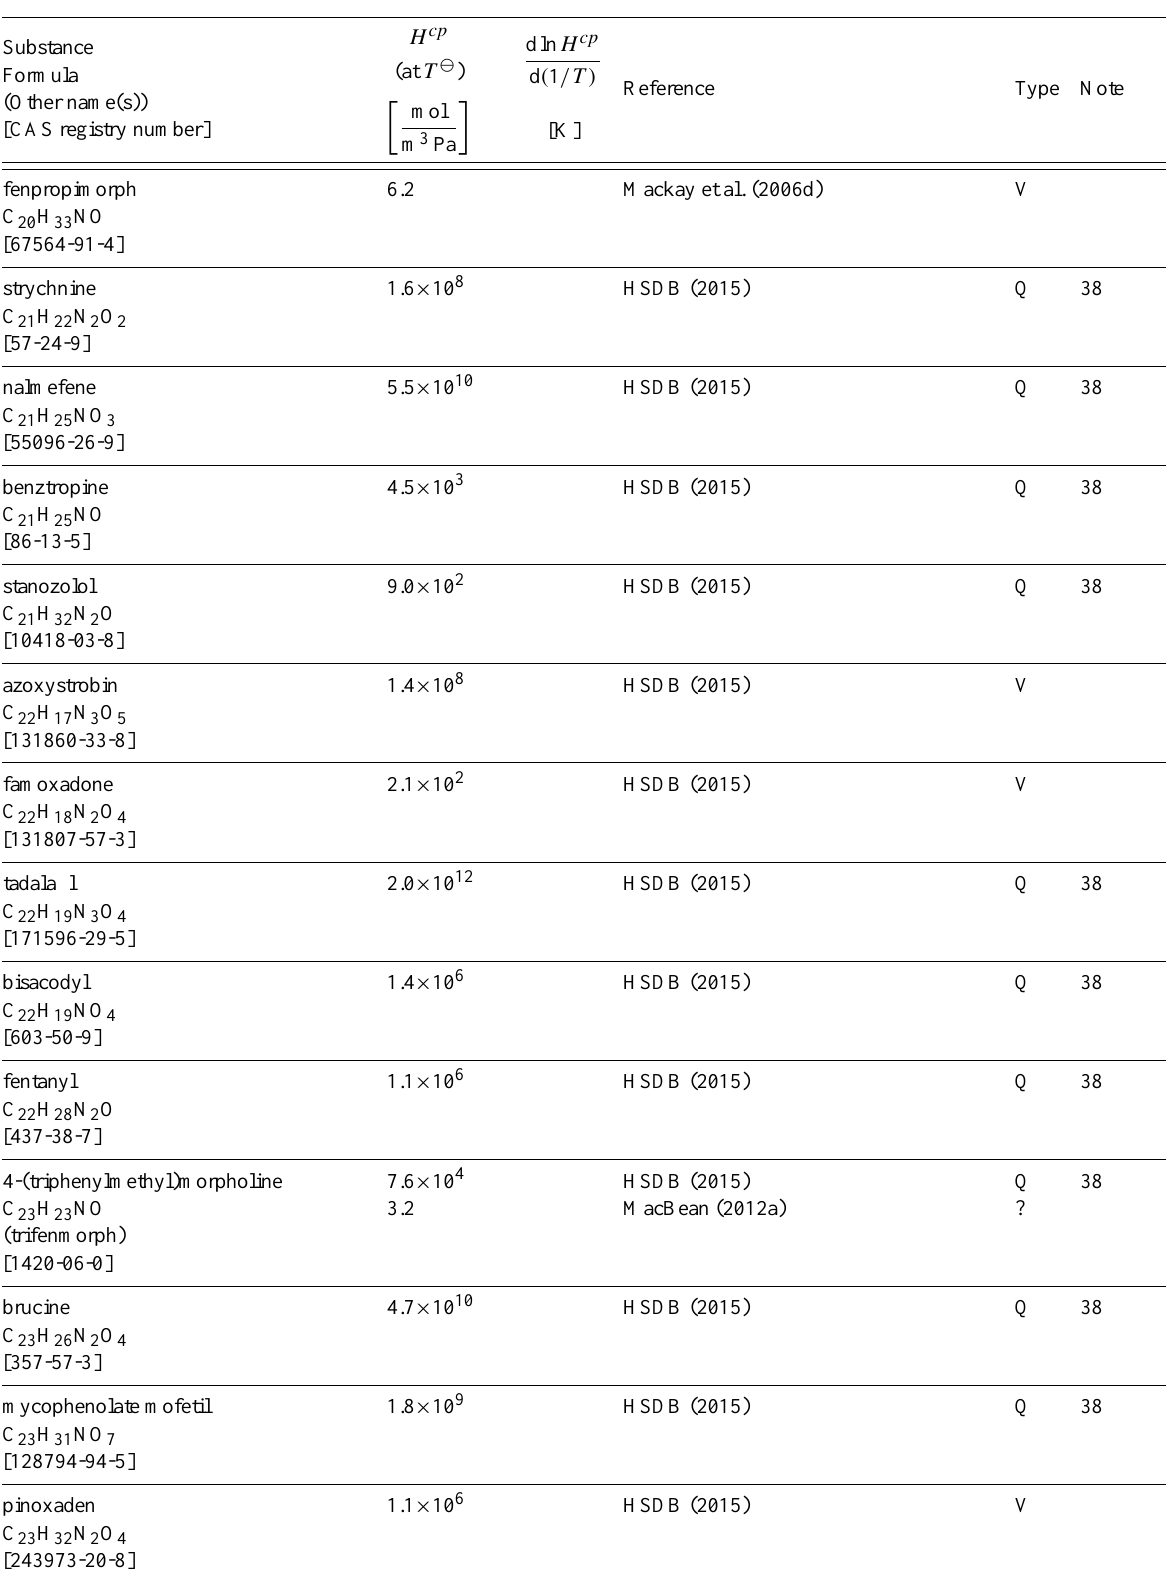
Table 6: Henry’s law constants for water as solvent